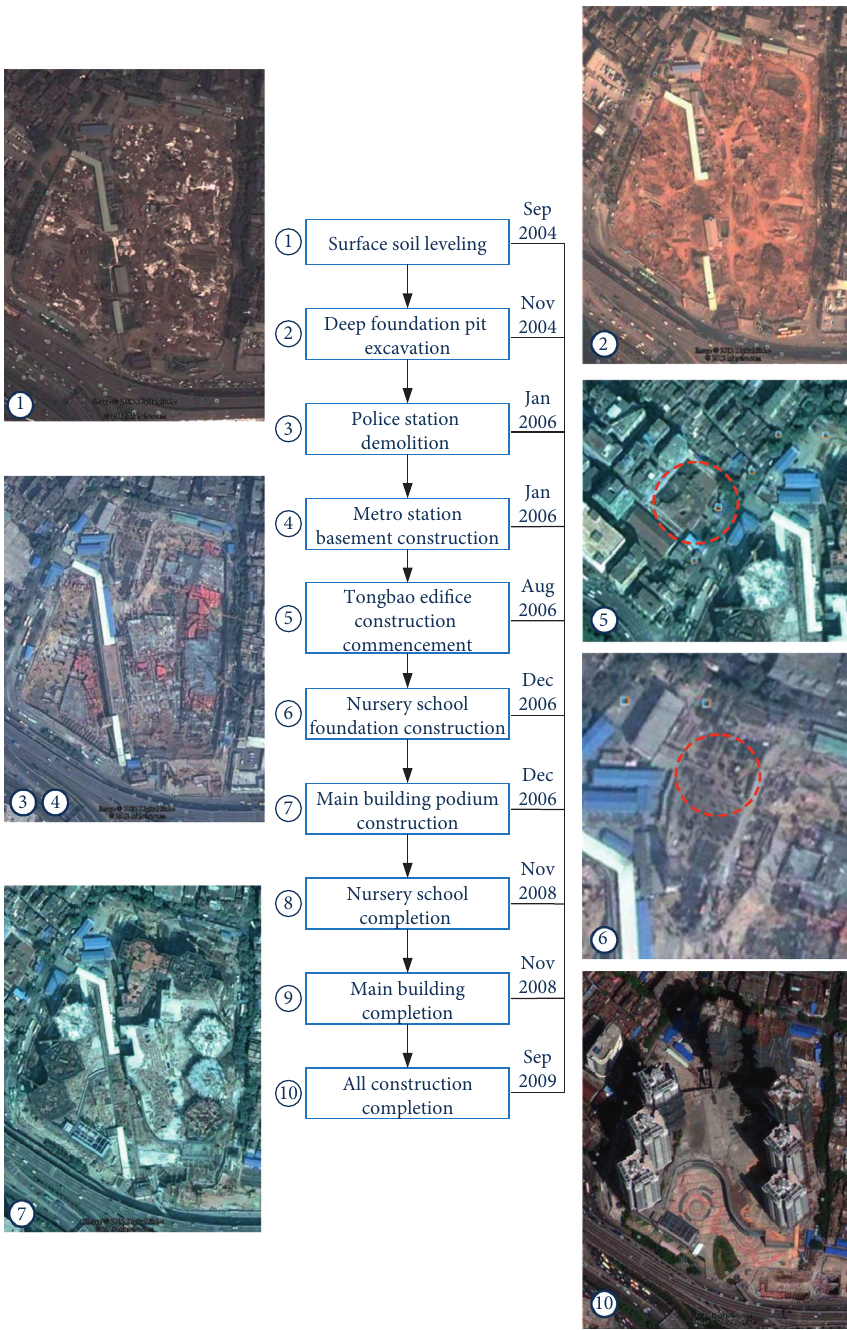
Figure 5: Flowchart showing the major stages of